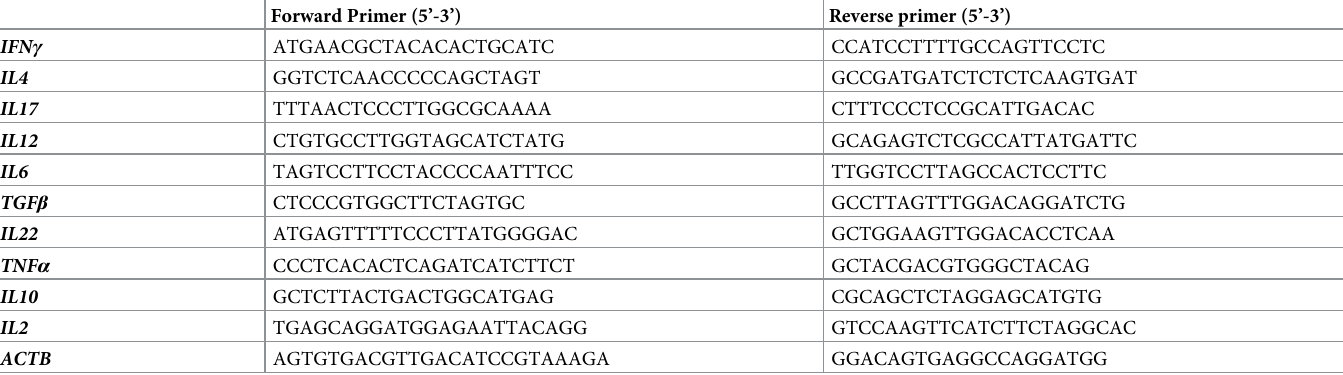
Table 1. Primers used for qRT-PCR